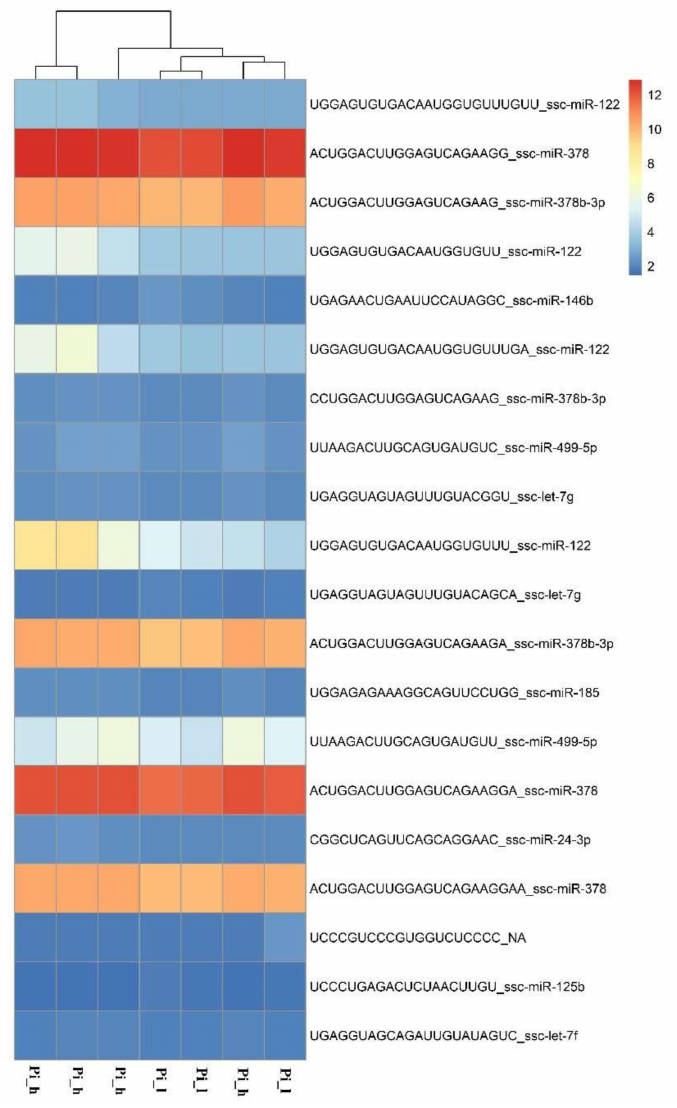
Figure 3. The expression pattern obtained for the most significant ( p < 0.01) miRNAs detected in Pietrain breed in pig groups differed in muscle weight (h, l,—high or low muscle mass) (R Package pheatmap, R Foundation for Statistical Computing, Vienna,